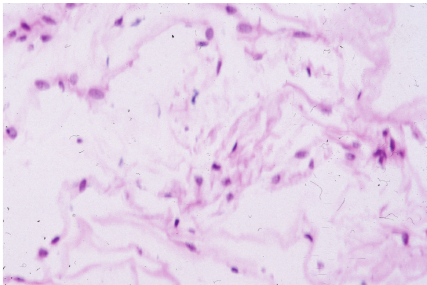
Figure 1: Hematoxylin and eosin 40x showing a paucicellular base- ment membrane composed of collagen fibers, glycosaminoglycans, laminin, fibronectin, and some